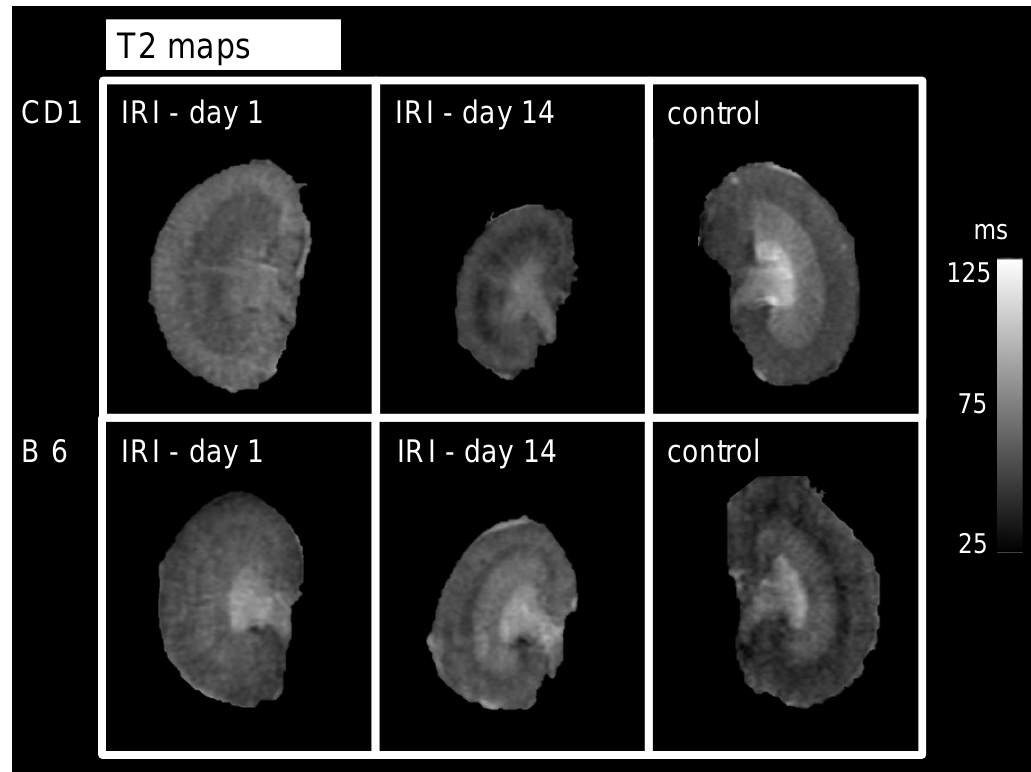
Figure 3. Examples of T2 maps of both mouse strains of the ischemic kidney on d1 and d14 after IRI as well as the control kidney (the contralateral, non-ischemic kidney on d1). T2-maps of the ischemic kidney of CD 1-mice (upper row) and B 6-mice (lower row) on d1 and d14 after unilateral clamping of the right renal pedicle for a duration of 35 minutes are depicted. The non-ischemic, contralateral kidney on d1 after surgery serves as an internal control. Window level and width as well as image size are similar for all parameter maps. Renal cortex and renal medulla of CD1-mice show more signal than B6 mice (reflecting more pronounced tissue edema). Note the reduction of kidney size on d14 in both mouse strains with accentuation in CD 1-mice. IRI = ischemia reperfusion injury, ms = milliseconds. Table 2. Relative values of T2 maps at d 1 and d14 after 35 min IRI.